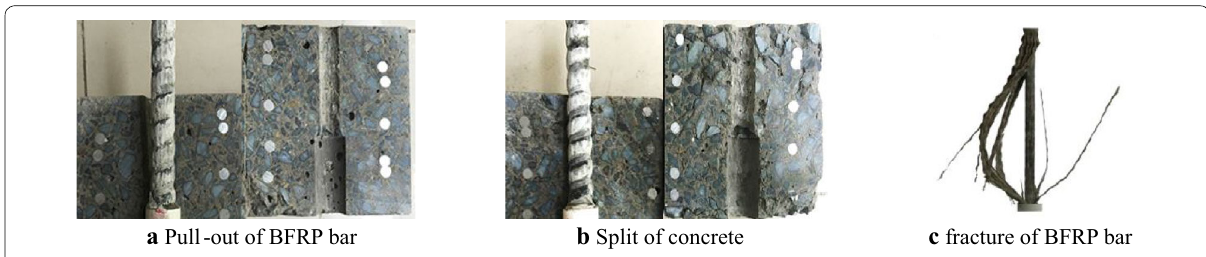
Fig. 5 Failure modes under cyclic